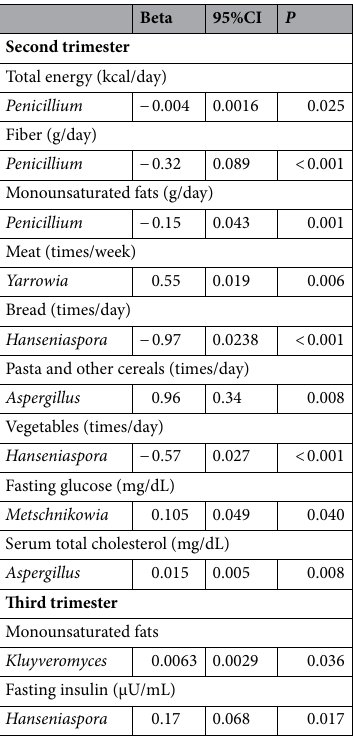
Table 1. Statistically significant associations between mycobiota composition and dietary and clinical variables in patients with GDM. Multiple regression model evaluating the association between the mycobiota relative frequency (dependent variable) and the dietary and clinical variables (independent variables), after adjustments for age and